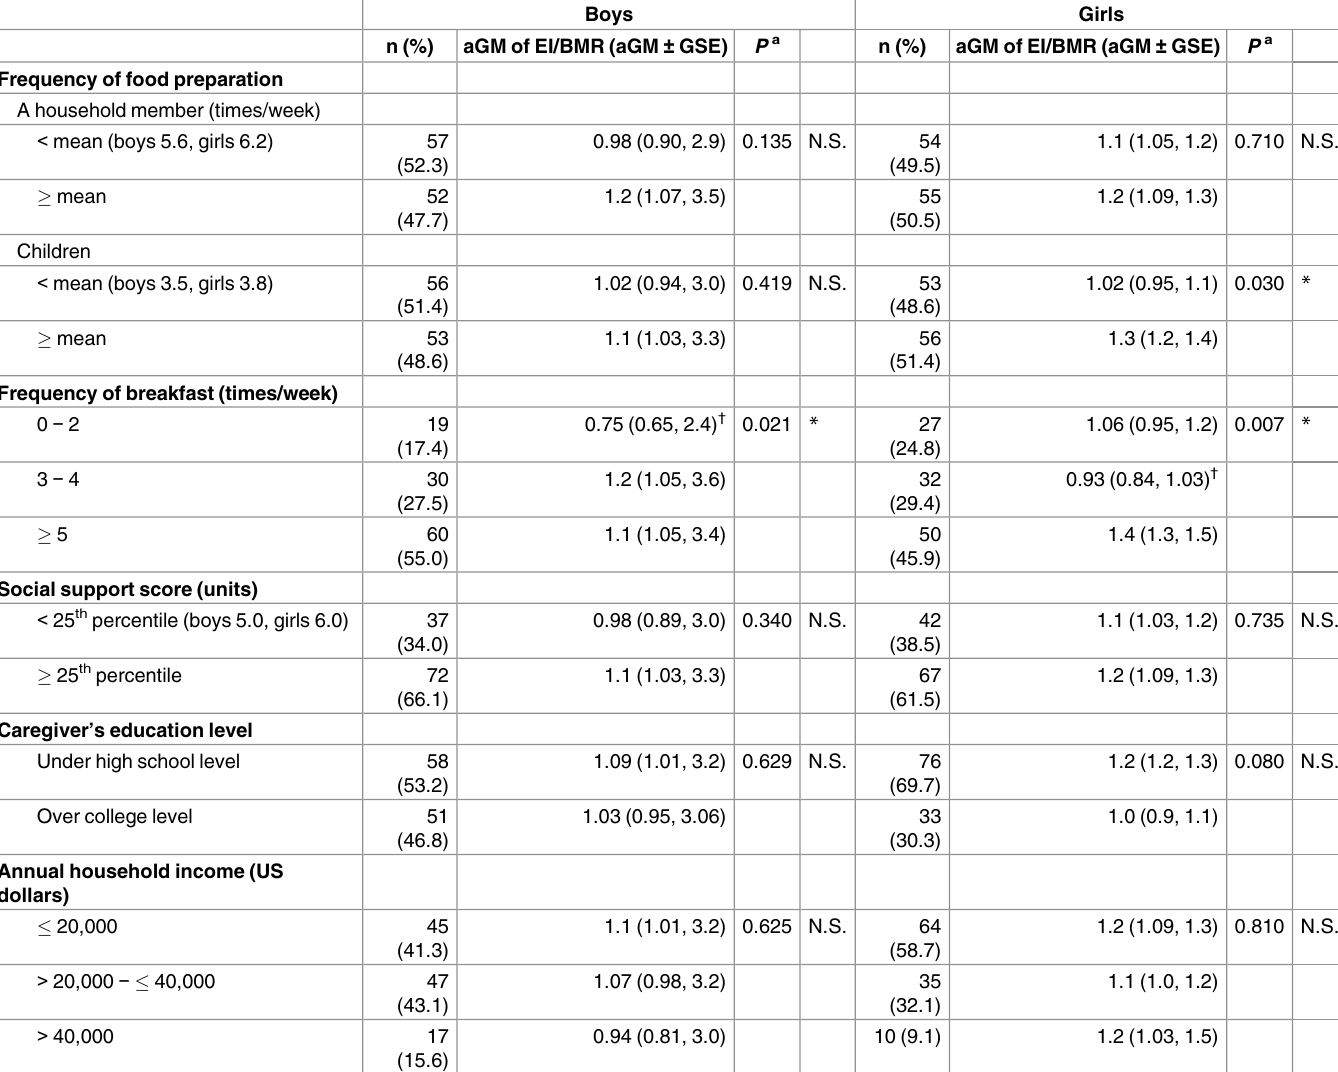
Table 3. The Differences in Age-Adjusted Mean EI/BMR by Dietary Habits, Social Support, and Socioeconomic